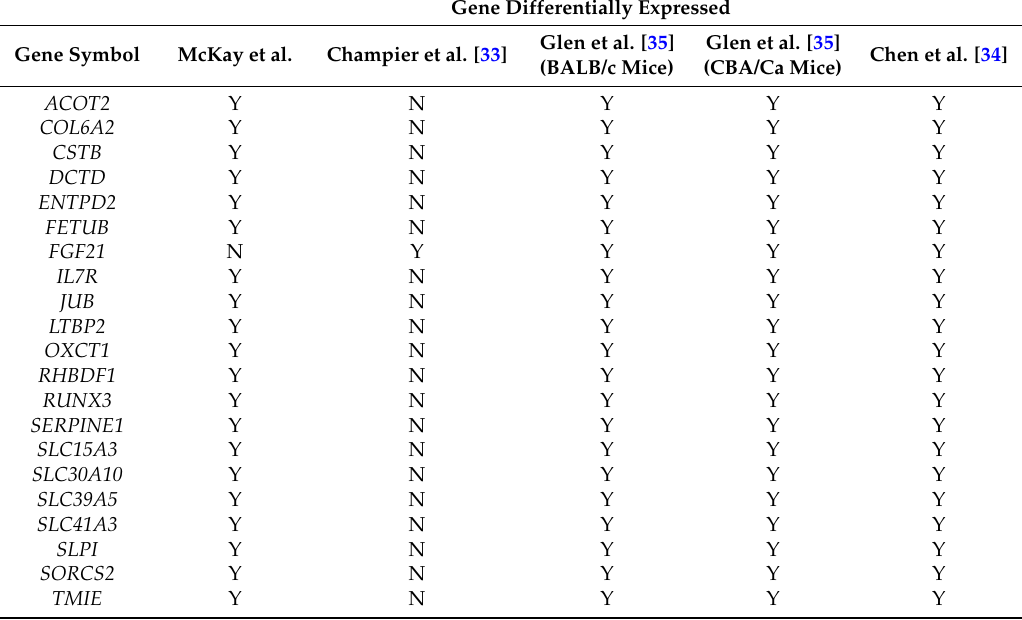
Table 11. Genes which were differentially expressed in response to low dietary folate/methyl donor intake in the liver across multiple studies 1